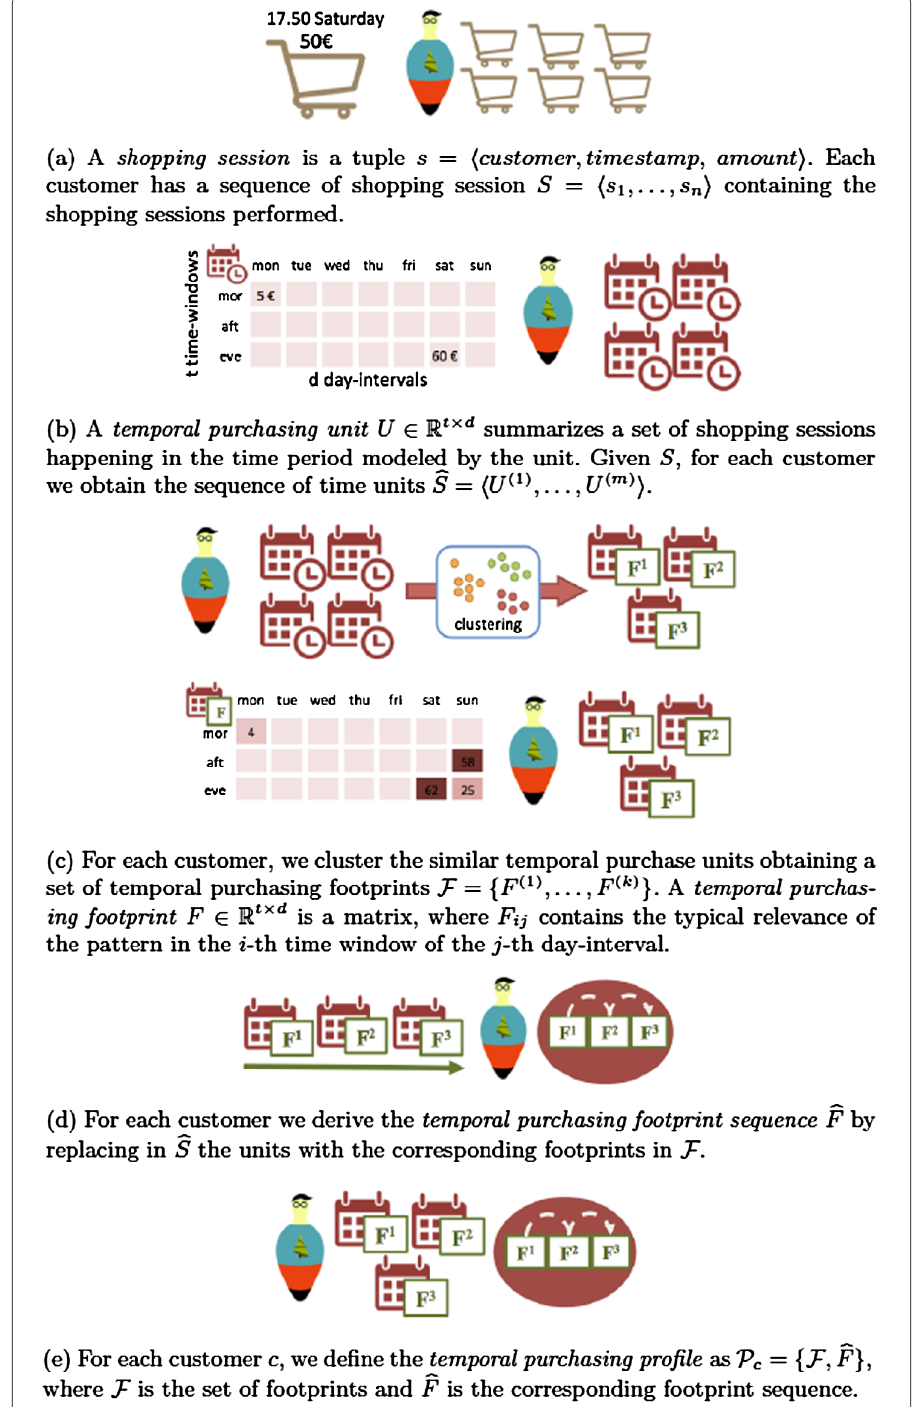
Figure 1 From shopping sessions to temporal purchasing profile